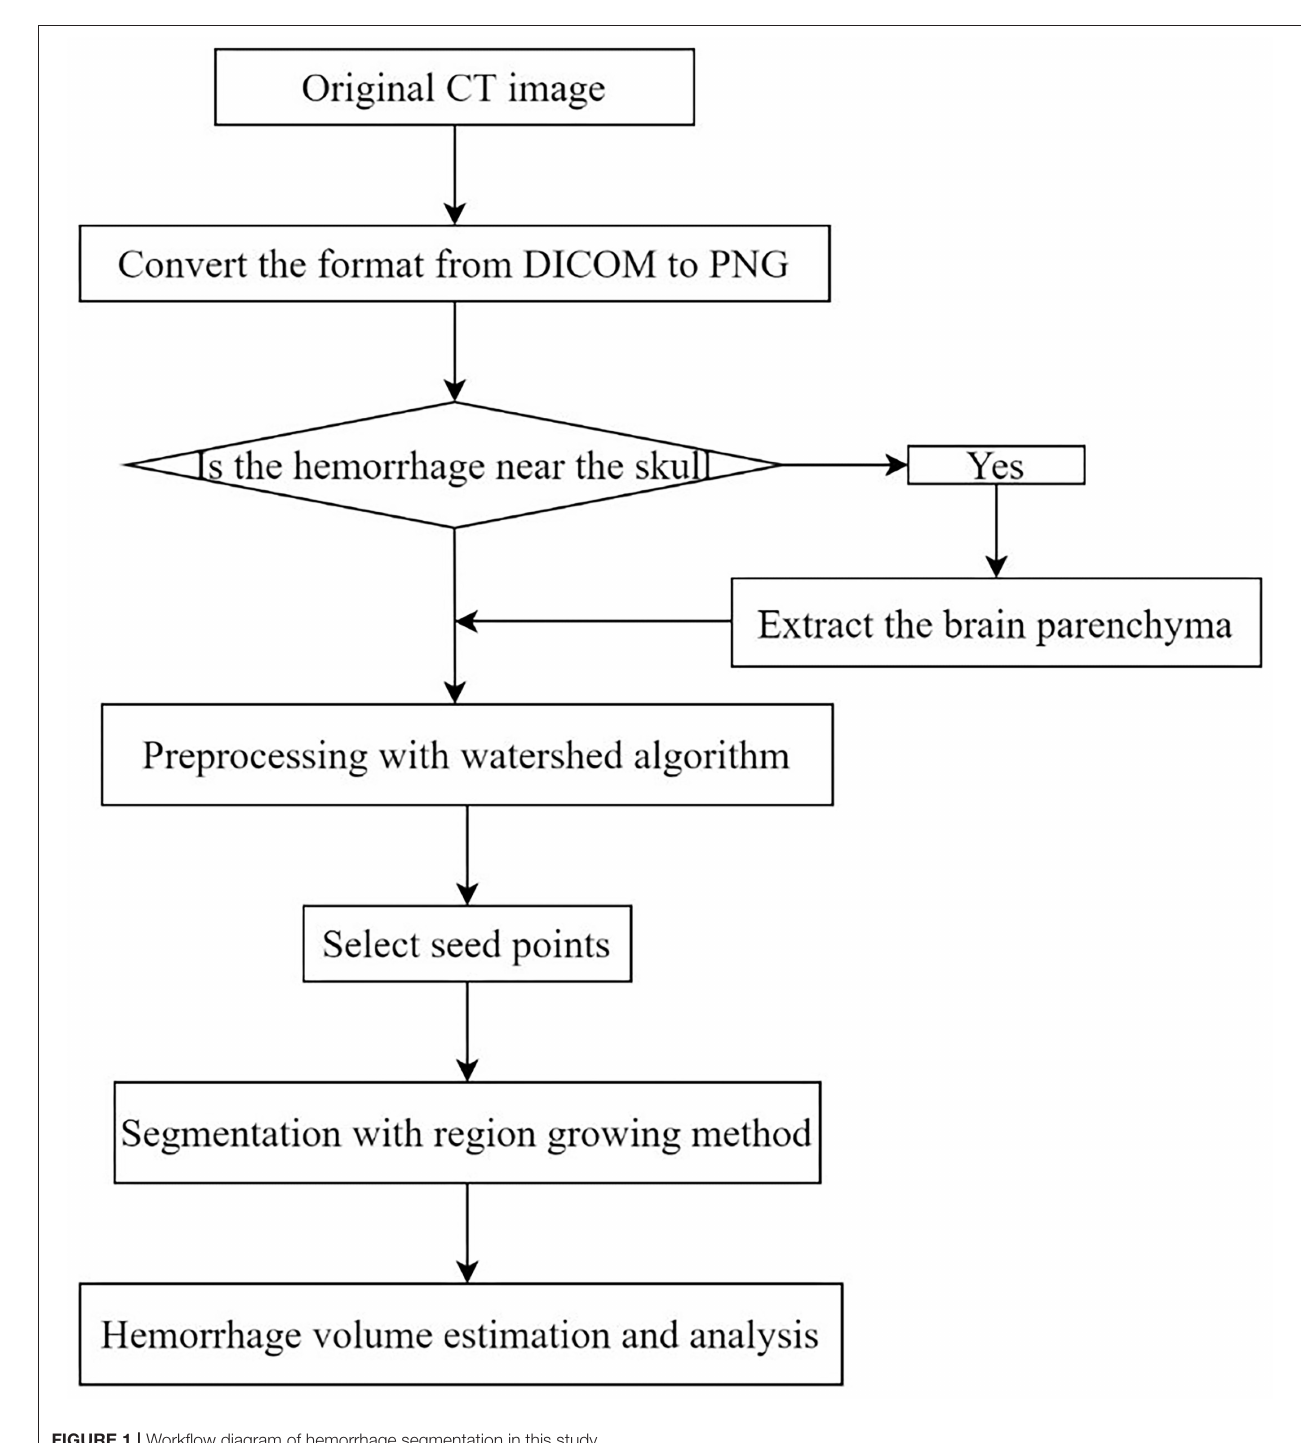
FIGURE 1 | Workflow diagram of hemorrhage segmentation in this